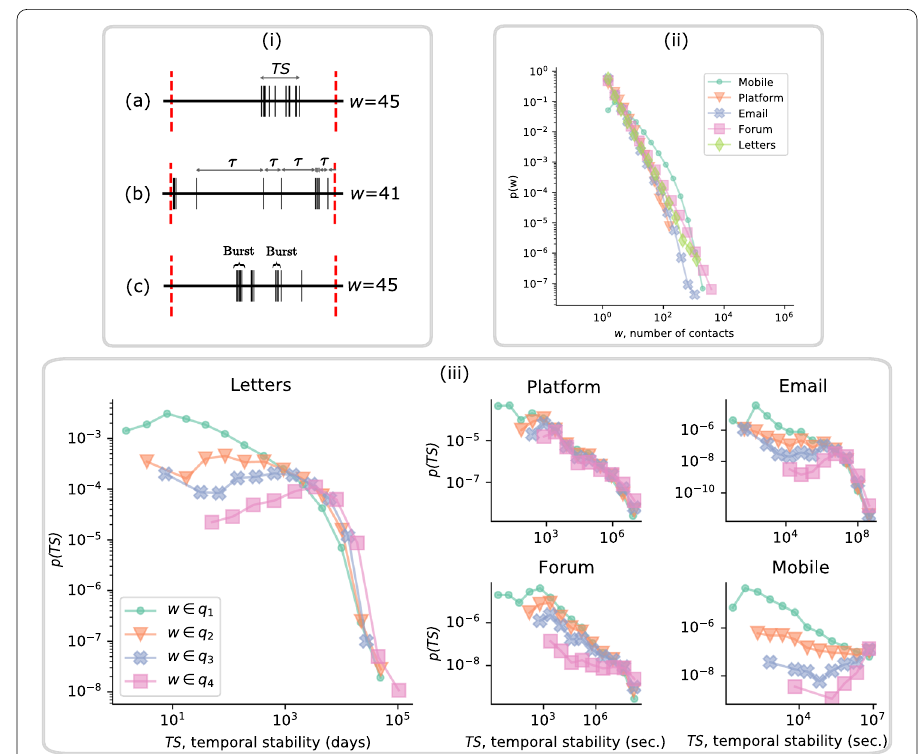
Fig. 3 Temporal features of human communication. ( i ) Visual representation of different temporal features for similar number of contacts, w . ( i , a) Temporal stability TS , where we only consider the first and last times during the observation period. ( i , b) Estimation of the inter‑event time (IET) distribution τ , the elapsed time between consecutive events. ( i , c) Example of bursty behaviour, where bursts of consecutive calls are followed by longer IETs. The burstiness coefficient is defined as B = σ − µ for µ , σ the mean and standard σ + µ deviation of τ . ( ii ) Empirical distribution of number of contacts w for the epistolary dataset and four reference datasets. ( iii ) Empirical distribution of temporal stability TS for the epistolary and reference datasets. For each case, we plot the distributions conditioned on link weight quartiles. For ease of comparison, we do not include individual data points, but present averaged binned values